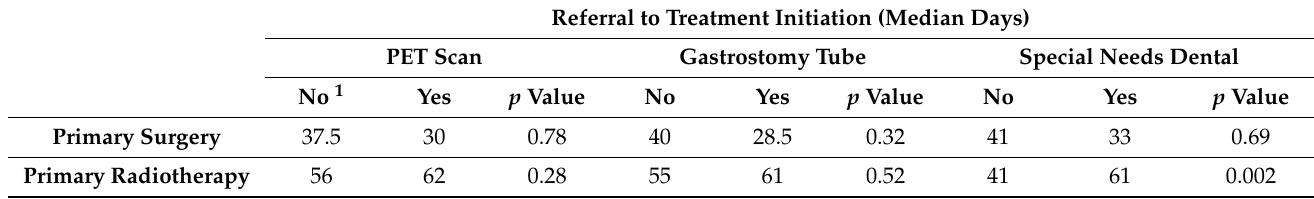
Table 3. Time from referral to treatment initiation for primary treatment